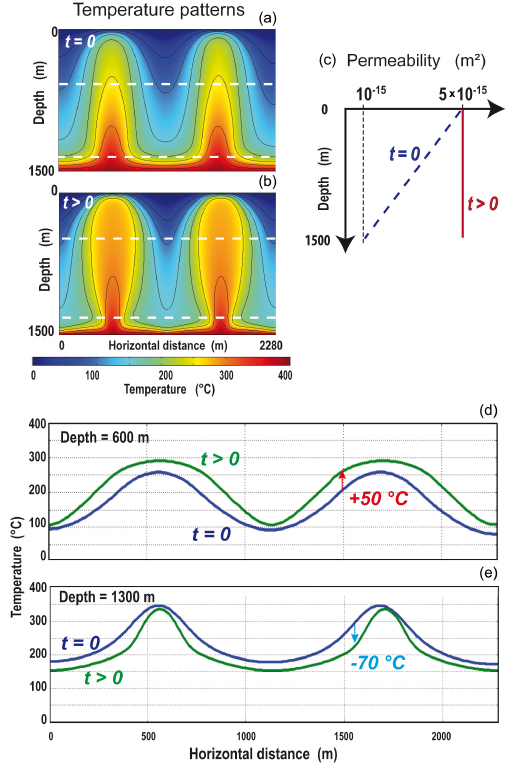
Figure 3. Effect of a sudden increase in permeability: from a depth- dependent variation (dashed line in c ) to a higher constant perme- ability (red line). Temperature patterns (a, b) show that the initial triangular-like geometry ( t = 0) of the upwellings evolves toward a bulb-like geometry. Panels (d) and (e) show the temperature vari- ations along the white dashed lines illustrated in the temperature patterns. The bulb-like regime involves higher positive temperature anomalies in the upper part of the system (up to 50 ◦ C) and higher negative temperature anomalies in the lower part (down to − 70 ◦ C).